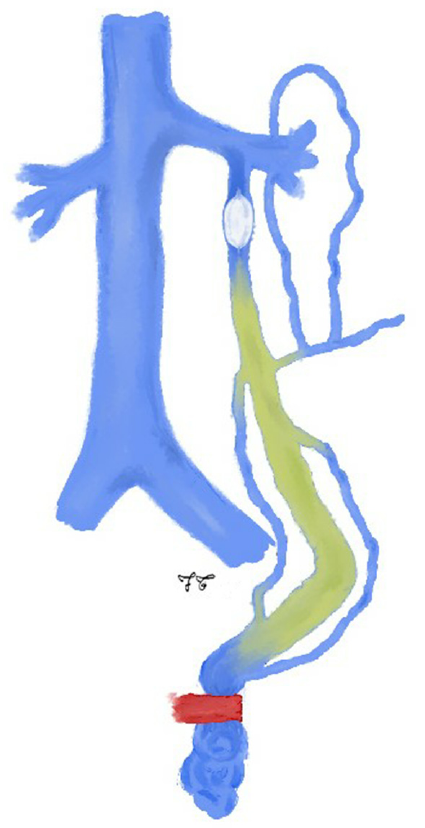
Figure 4. Drawing shows spermatic vein embolization with sclerosing agent according to occluding balloon technique: this technique refers to the use of a temporary proximal OB catheter in addition to distal barrage, to stop the retrograde blood flow. The sclerosing agent is injected through the OB catheter into the distal portion of the ISV.